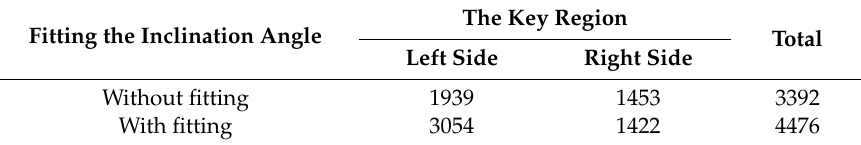
Table 1. The number of VOP extraction with or without fitting of the inclination angle between the BGP and the projection plane. The Key Region Fitting the Inclination Angle Total Left Side Right Side Without fitting 1939 1453 3392 With fitting 3054 1422 4476